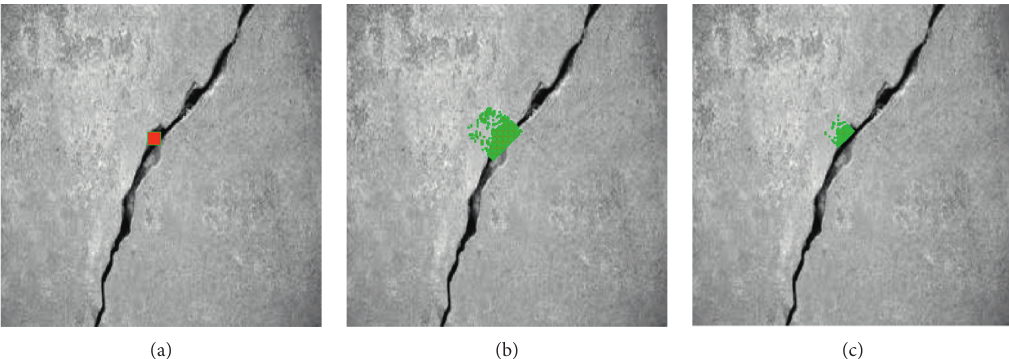
Figure 9: Percolation regions of pixel (100, 115) in image crack 23: (a) raw image; (b) without termination; (c) with